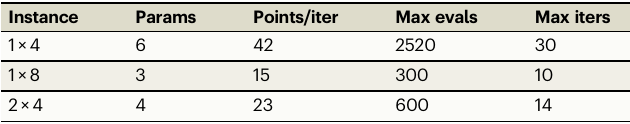
Table 1 | BayesMGD characteristics in